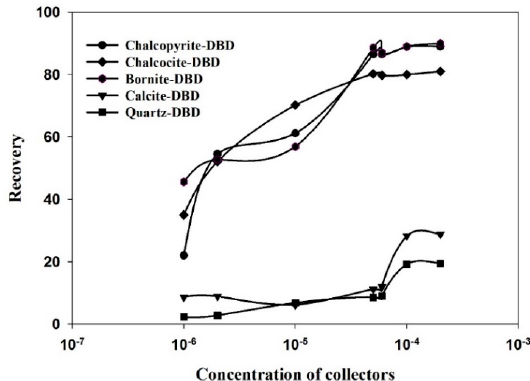
Figure 8. Hallimond flotation recovery as a function of collector concentration at a natural pH.